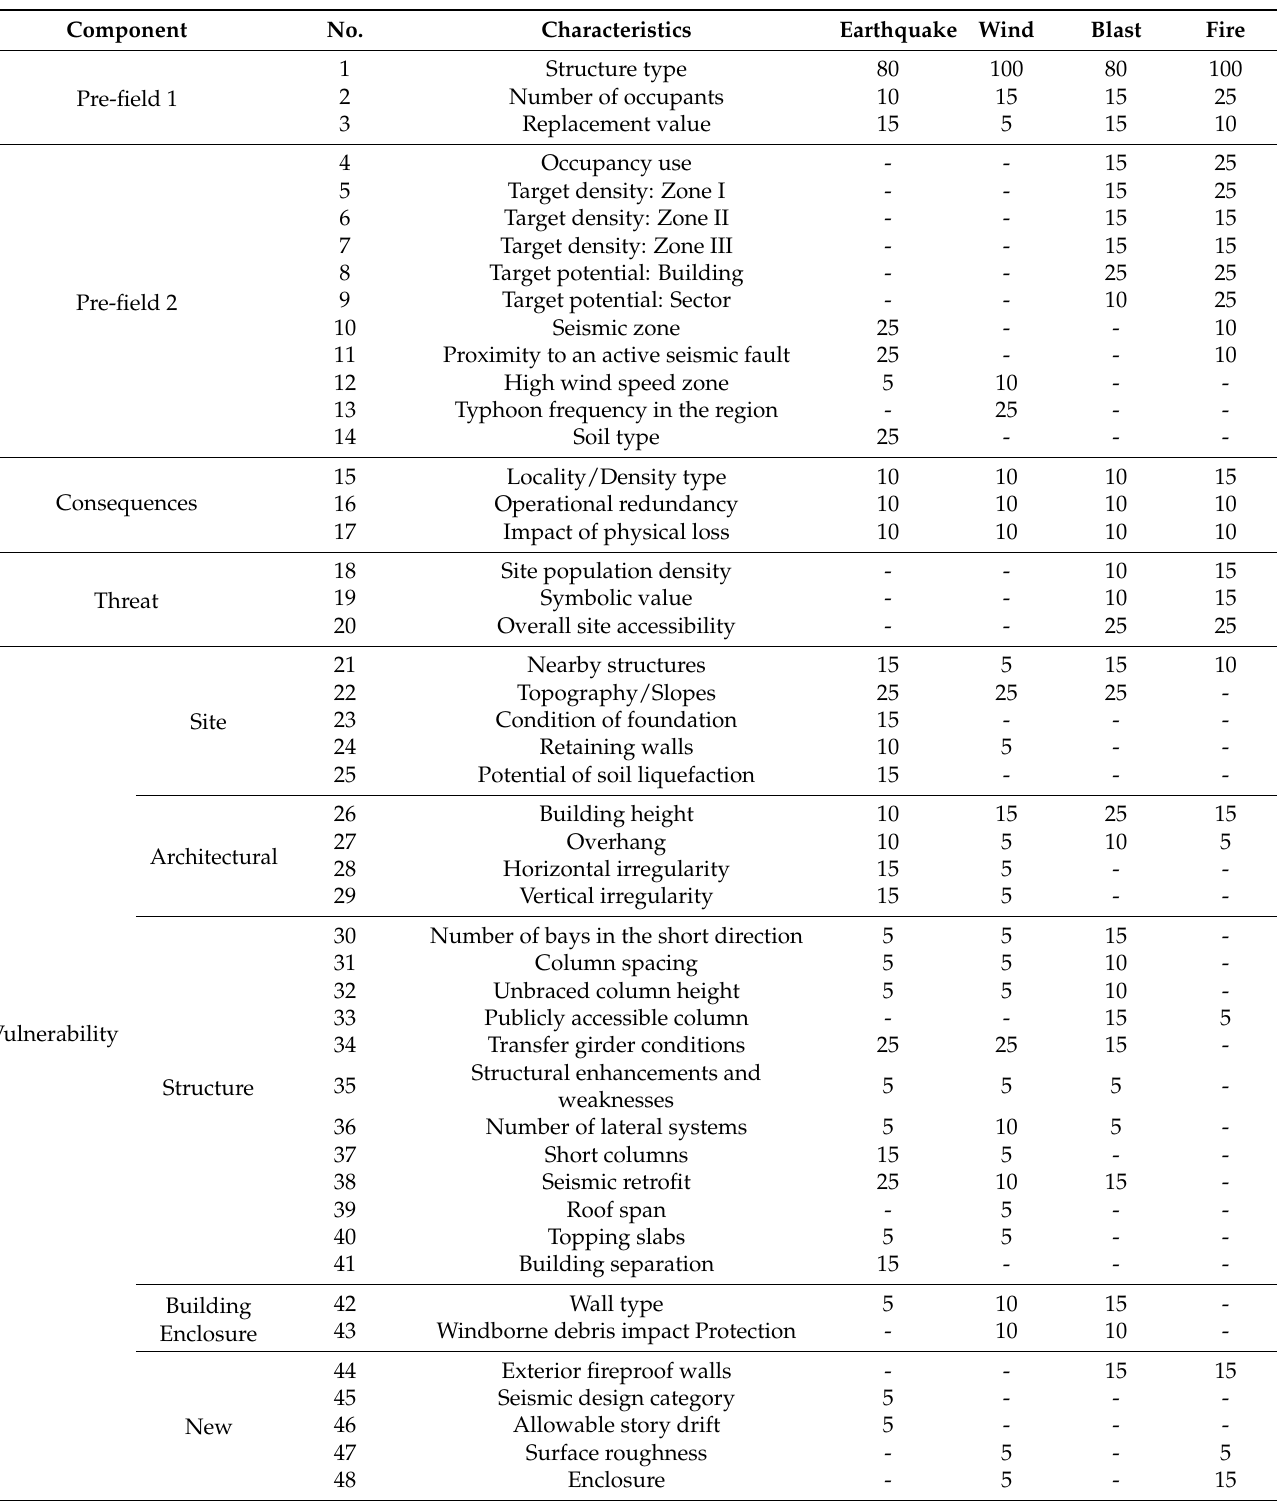
Table 8. Characteristics of weight values in